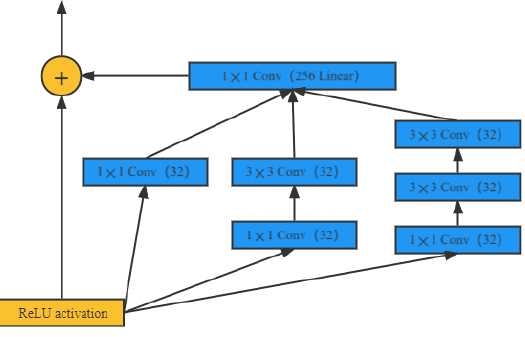
Figure 5. Illustration of